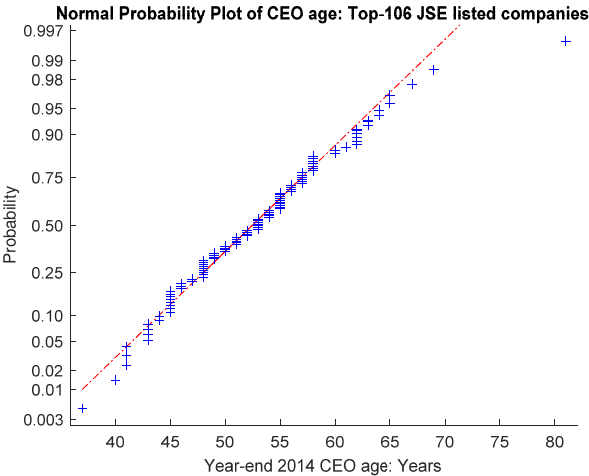
Fig. 2. Normal Probability Plot of CEO age for top-106 JSE listed companies